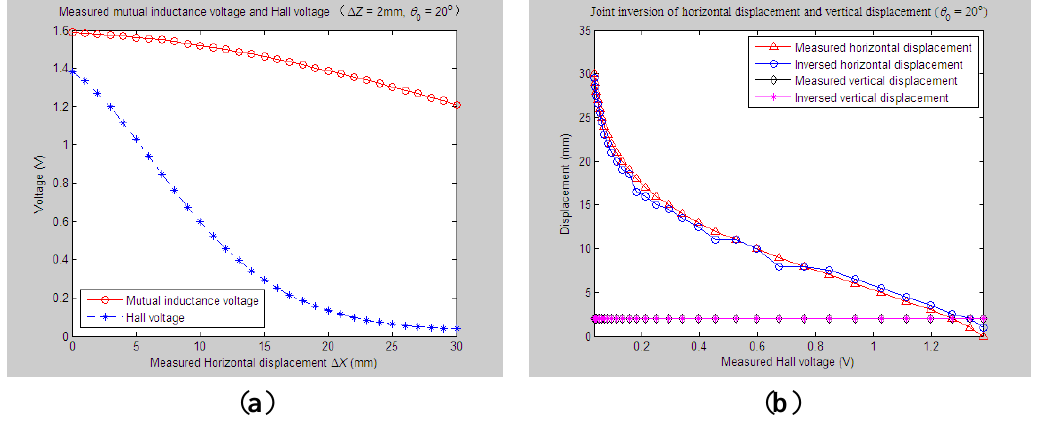
Figure 6. Horizontal and vertical displacement joint inversion results when measured Δ X are changed while the measured Δ Z remain stable ( θ 0 = 20°, Δ Z = 0 mm). ( a ) Measured mutual inductance voltage and Hall voltage; ( b ) inversed horizontal and vertical displacements.